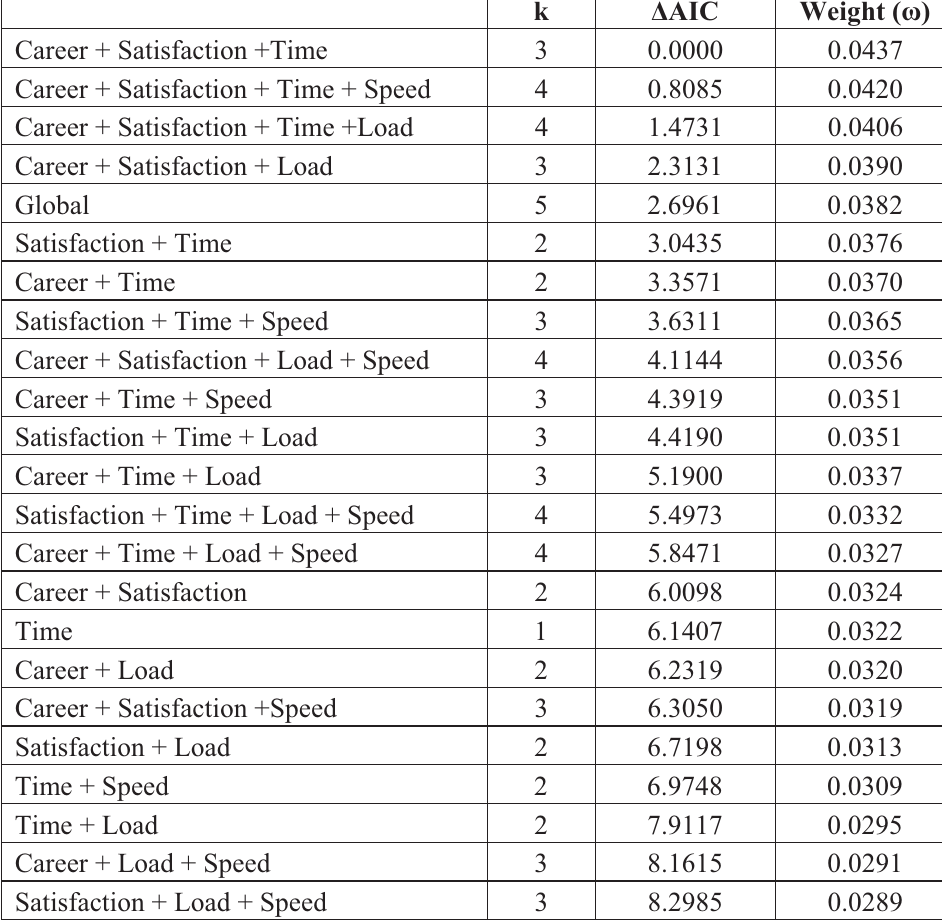
Table 4. Total pain results (k = number of